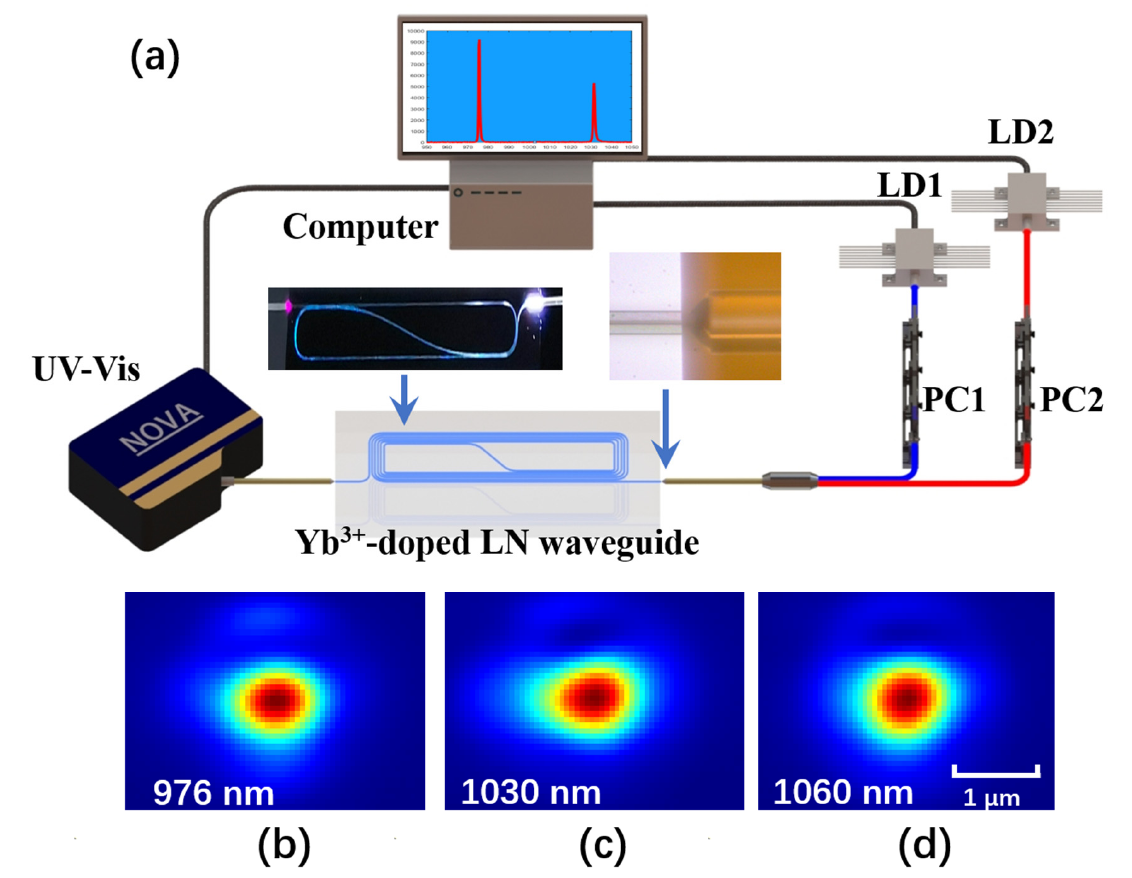
Figure 3. ( a ) The experimental setup to characterize optical amplification of YDWA. Insets show the photograph of the YDWA (left) and the coupling lensed fiber (right). The infrared images of the output port of the fabricated Yb 3+ -doped waveguide with wavelength ( b ) 976 nm laser beam, ( c ) 1030 nm laser beam, and ( d ) 1060 nm laser beam. (LD: laser diodes; PC: polarization controllers; UV-Vis: ultraviolet-visible spectrometer.)